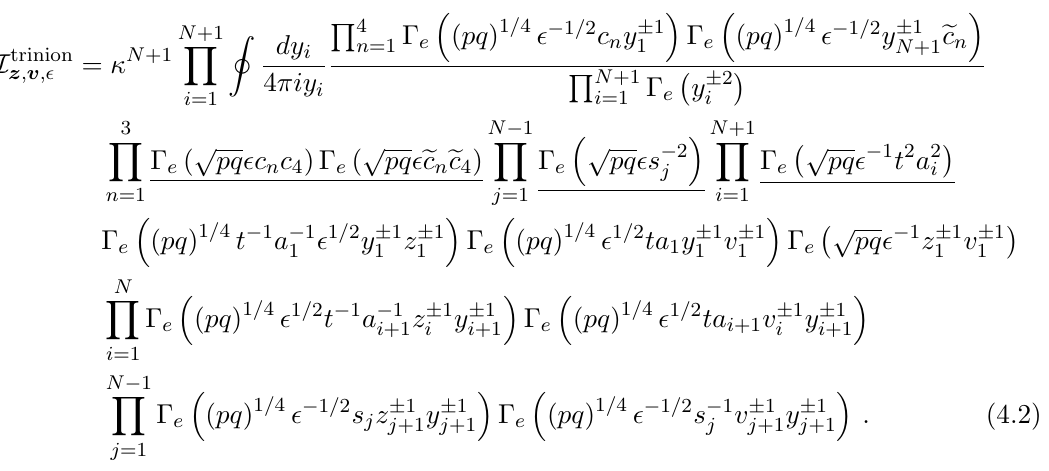
Figure 9 . A quiver diagram for a compacti(cid:12)cation of minimal class D N +3 conformal matter on a sphere with two maximal and one minimal punctures. All (cid:12)elds have R-charge 1 = 2 except the gauge singlet (cid:12)elds that have R-charge 1. (cid:15) is the fugacity associated to the additional SU(2) puncture, while a i , s j and the two SU(4)’s are related to the internal symmetries that arise from 6 d . In blue we write the (cid:12)eld names, in red we write the fugacities associated to puncture and gauge symmetries, and in black we write the fugacities of each (cid:12)eld. The X ’s on bifundamental (cid:12)elds denote (cid:13)ip (cid:12)elds coupled through the superpotential to baryonic operators built from the bifundamental (cid:12)elds. Six additional (cid:13)ip (cid:12)elds need to be included as well, three (cid:13)ipping half of the six operators in the symmetric representation of each of the SU(4)’s. These break each of the two SU(4) symmetries to SU(3) (cid:2) U(1). In addition, each closed loop of (cid:12)elds has a superpotential term turned on for it. The superconformal index for the trinion